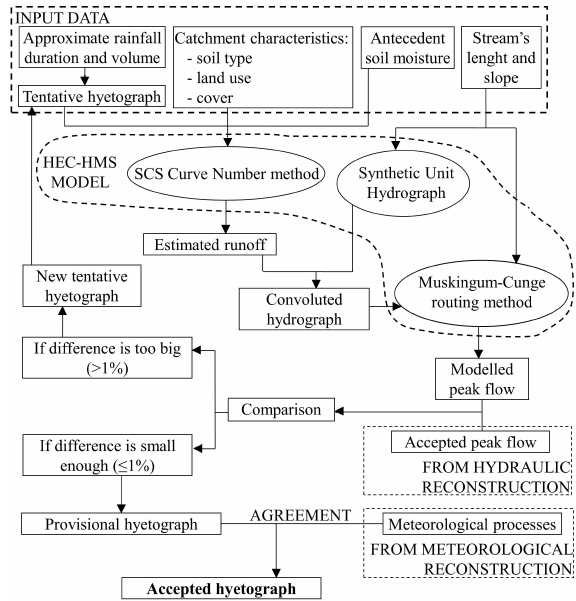
Figure 6. Iterative procedure used in the hydrological reconstruc- tion of hyetographs (modified from Balasch et al.,